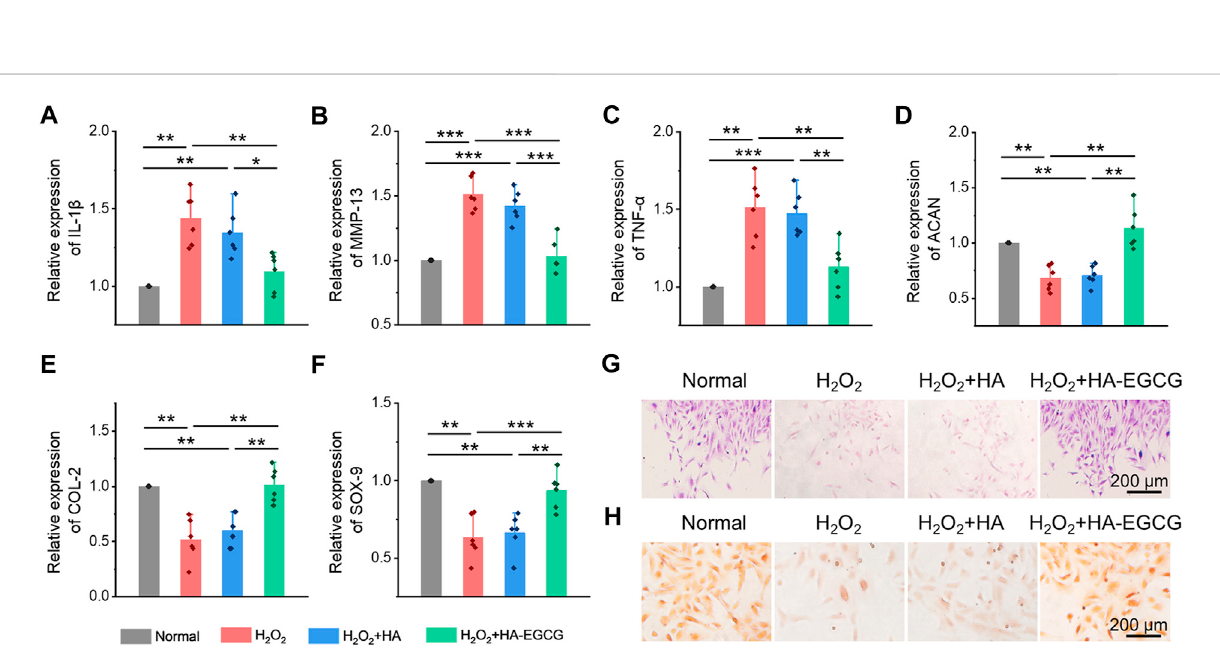
FIGURE 5 Inhibition in fl ammatory cytokines expression and inductionchondrogenic differentiation of ADSCs under oxidativestress. (A – C) Real-time PCR analysis of in fl ammatory cytokines IL-1 β , MMP-13, and TNF- α in ADSCs under oxidative stress ( n = 6). (D – F) Real-time PCR analysis of chondrogenic-related genes ACAN,COL-2,andSOX-9inADSCsafterchondrogenicinduction( n =6). (G) AlcainbluestainingofADSCs. (H) SafranineOstainingofADSCs(* p < 0.05,** p < 0.01, and *** p <